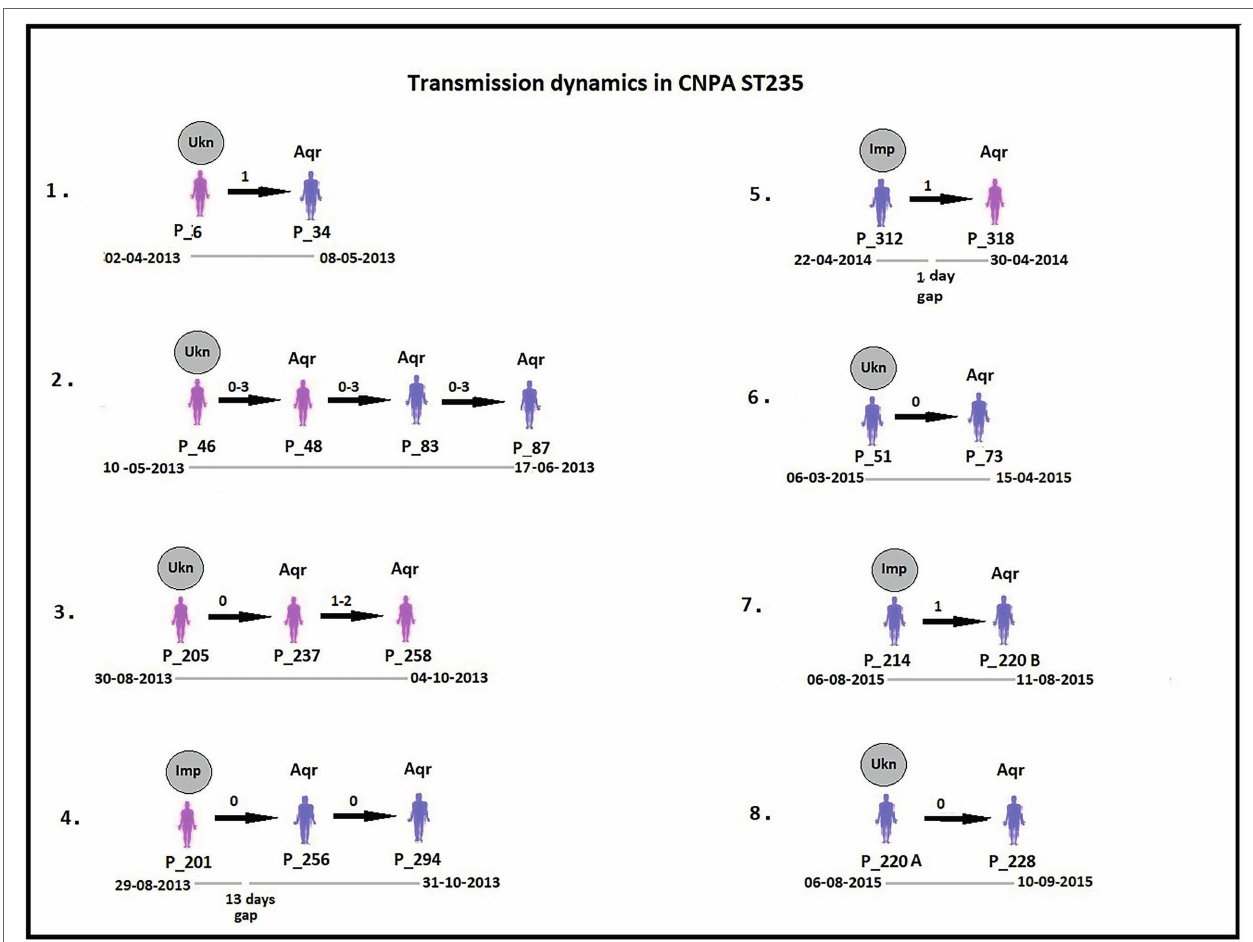
FIGURE 6 | Potential transmissions of CNPA ST235 isolates among the patients (their ID given as “P_”) are shown in the figure. Pink colored patients are from adult-ICU and purple colored patients are from ER-ICU. Strain relatedness in terms of pairwise wgSNP distances (0–4) among the strains is shown on the respective arrow between the two patients harboring strains associated with the transmission event. In some patients, more than one isolate was collected, therefore the pairwise wgSNP distances have a range between the two patients. All these transmissions are arranged in ascending order according to their time of admission to the ICU and their sample collection dates from the year 2013 to 2015. The gray circle above first patient in each transmission event denotes that CNPA strain either imported (if labeled as “Imp”) from outside at the time admission or acquired from unknown (if labeled as “Ukn”) source within the ICU. Other patients in each transmission chain labeled as “Aqr” which means they acquired these clones during hospitalization. The hospitalization time line of the patients is shown below each transmission chain. The gap in the time line depicts that there is a time difference between discharge of one patient and admission of another to the